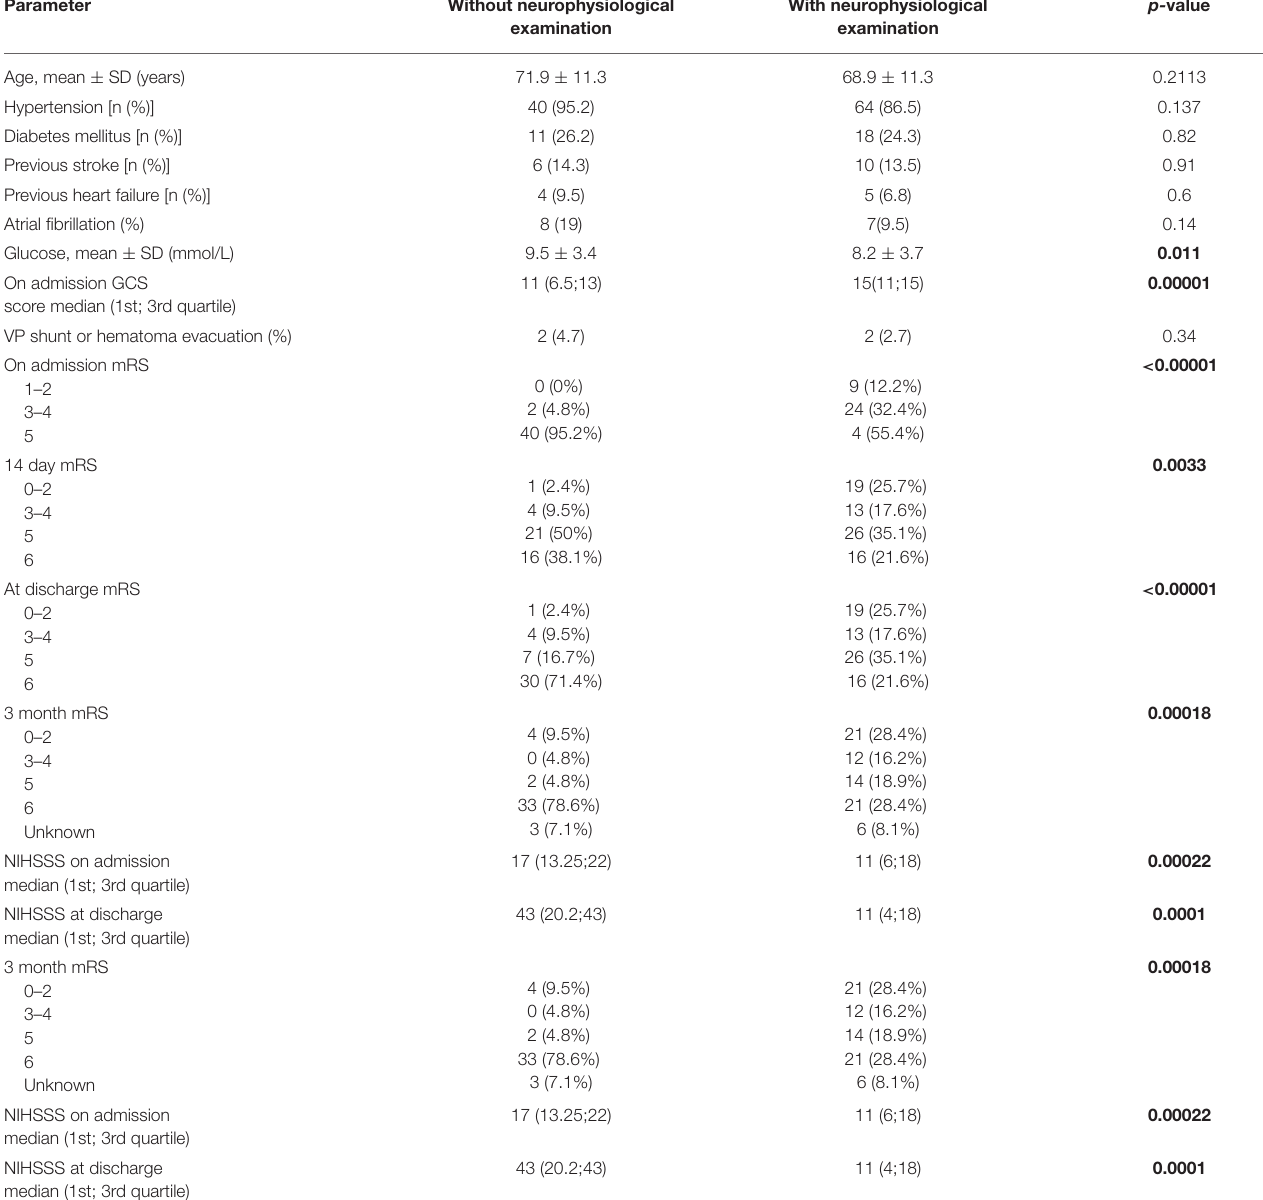
TABLE 4 | Comparison of important parameters and outcome of the groups with and without neurophysiological examinations. Parameter Without neurophysiological